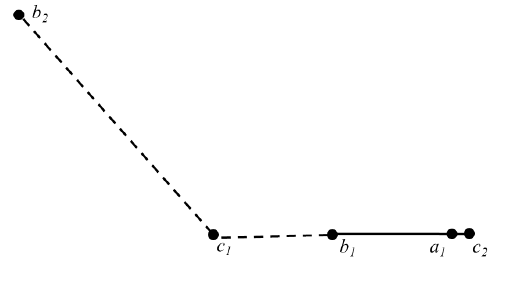
Figure 5. An example resulting in a larger itemset having a smaller cohesive distance.